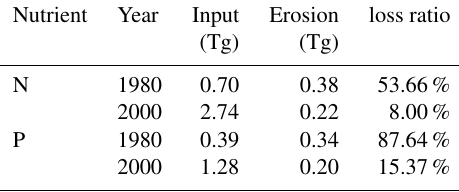
Table 4. Comparison of fertilizer inputs (N and P) and losses due to topsoil erosion (Tg) on arable land on the CLP in 1980 and 2000. Nutrients inputs were estimated by multiplying fertilizer input per unit area (kgha − 1 ) (Wang et al., 2014a) with the total cropland area (ha). Nutrient losses due to erosion were estimated by multiplying the amount of sediment mobilized by topsoil erosion and the nutri- ent content of topsoil under different land uses (Liu et al.,